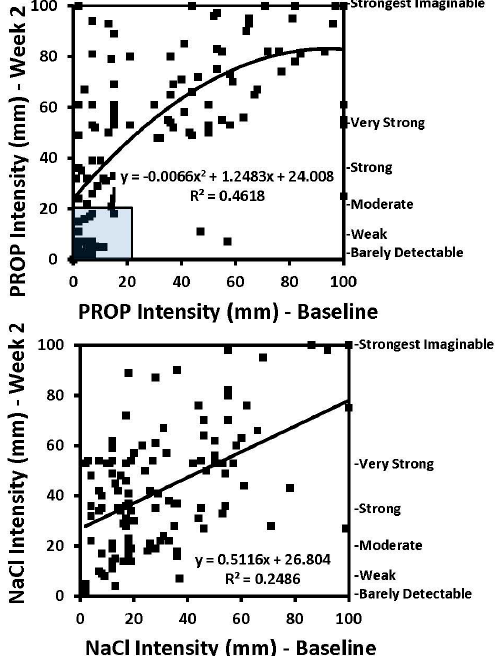
Figure 5. Regression of intensity ratings for 6- n -propylthiouracil (PROP; top panel ), and NaCl ( bottom panel ), at baseline and at two weeks after smoking cessation (controlling for age and gender). Intensity ratings were made using the Labeled Magnitude Scale (0–100 mm). Intensity ratings for both stimuli increased across the trial. PROP intensity ratings have a logarithmic trend line, while NaCl ratings have a linear trend line. Mean intensity ratings for both stimuli rose from baseline to week 2 (for NaCl, 30.2 ± 2.1 vs. 42.3 ± 2.1 and for PROP, 35.9 ± 3.3 vs. 53.2 ± 2.9; p < 0.01 for both). n = 120. The shaded box identifies a small group of participants who were classified as PROP non-tasters at both. Data are from Ahijevych et al. [57] with permission.